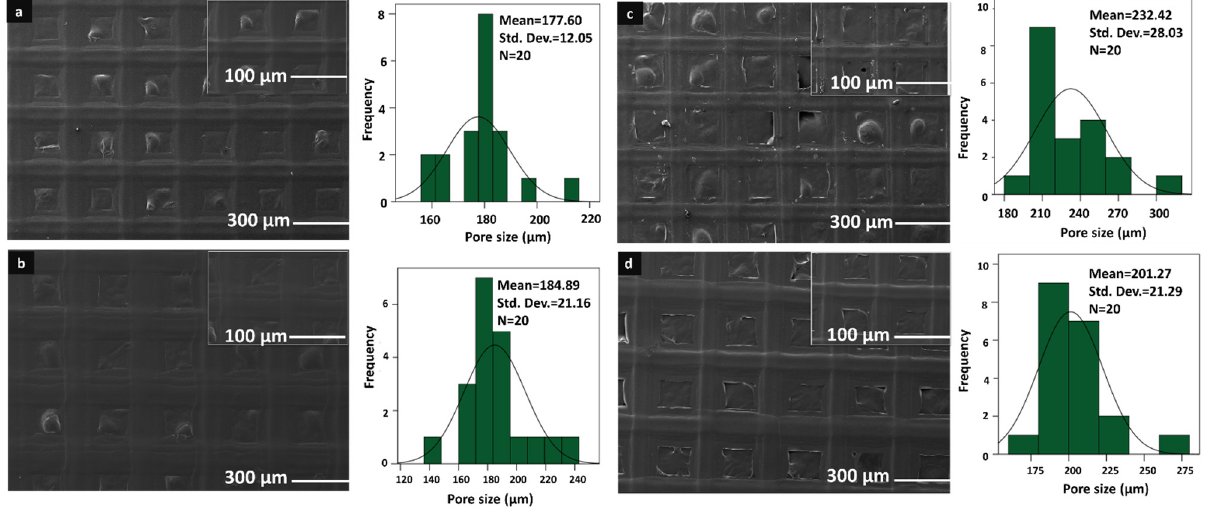
Figure 1. SEM images and histograms of the 13% PVA ( a ), 13% PVA/1% S ( b ), 13% PVA/2% S ( c ), and 13% PVA/3% S ( d ).